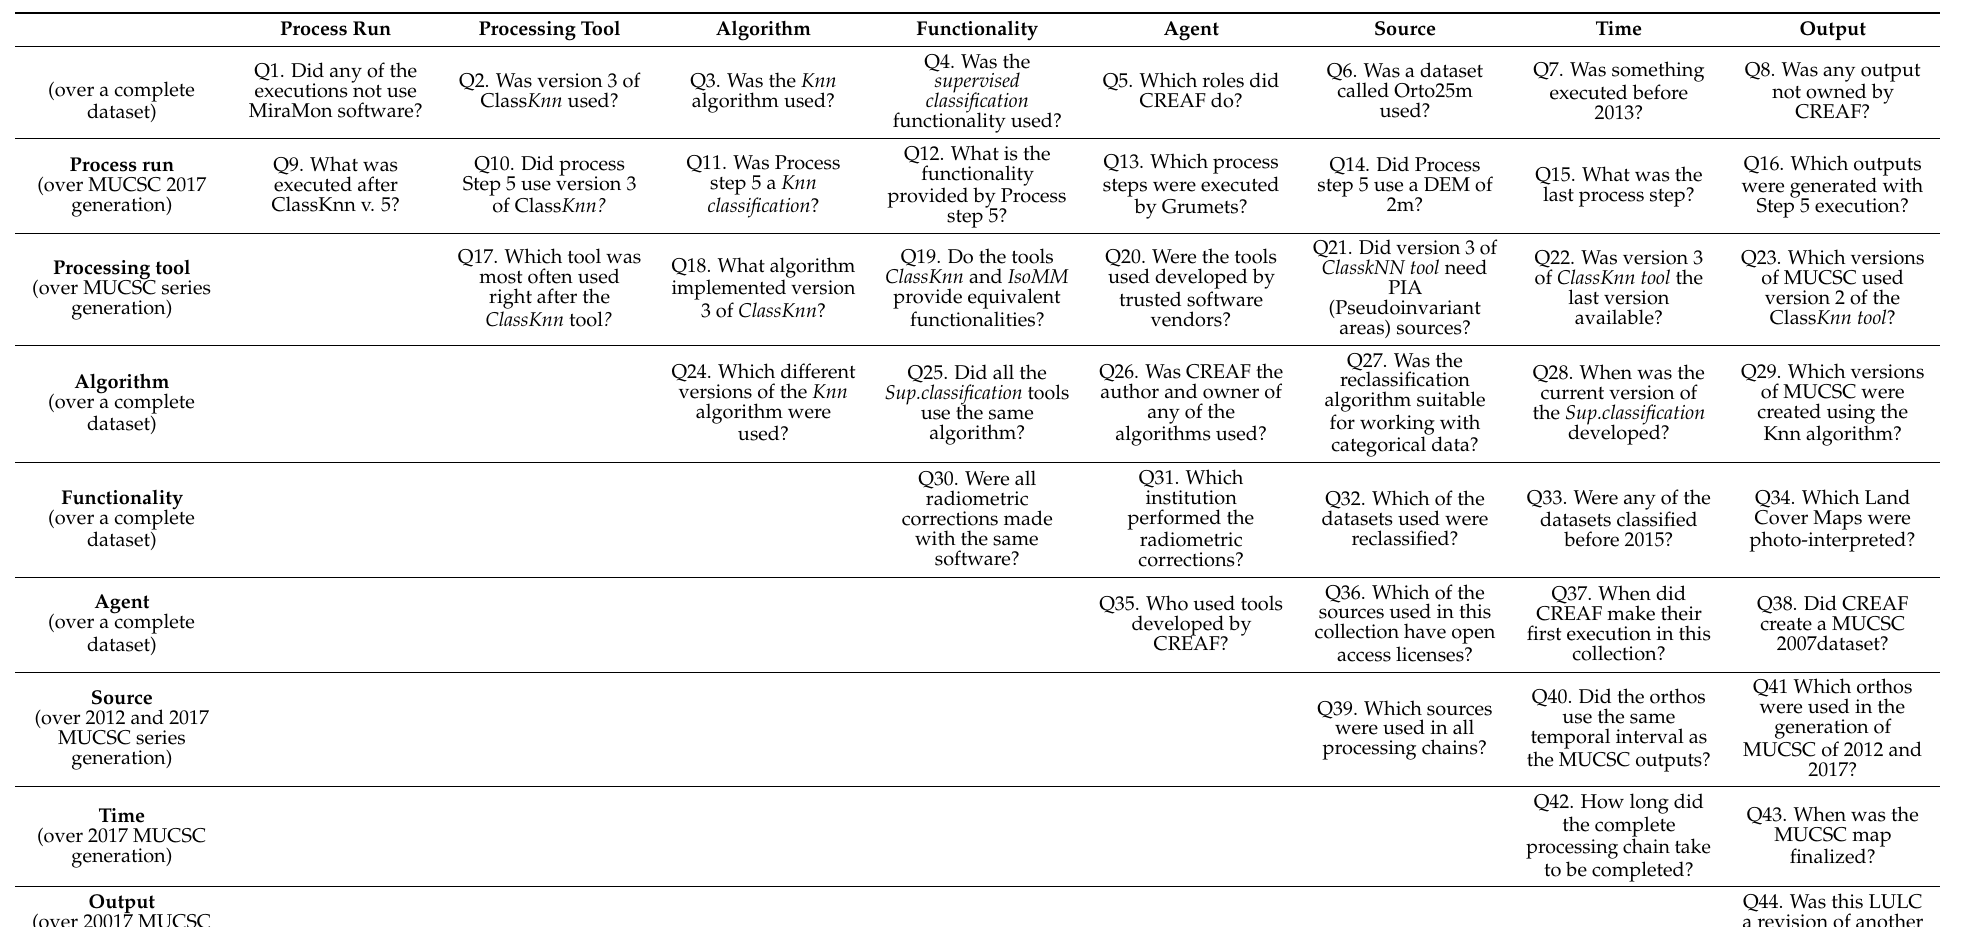
Table 4. Forty-four examples of queries that can be formulated on the Catalonia Land Cover